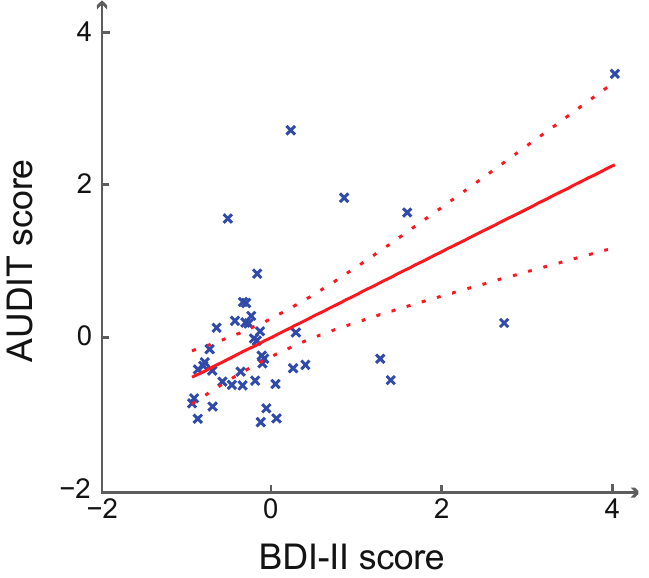
Figure 2. Scatter plot of AUDIT and BDI-II scores. Note that the standardized residual scores after controlling for age, sex, and FTND score as covariates are shown here. Dashed lines represent 95% confidence intervals of the mean regression (solid line). Crosses represent individual data points.